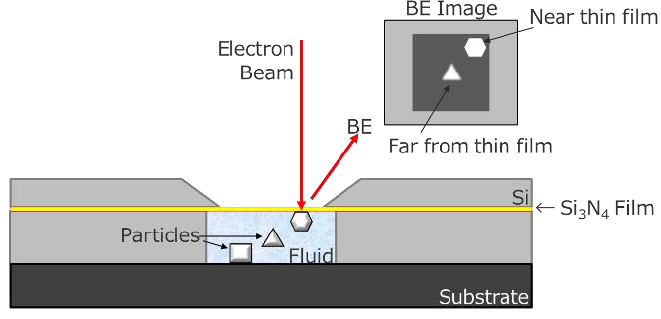
Figure 3. Schematic draw of in situ holder.